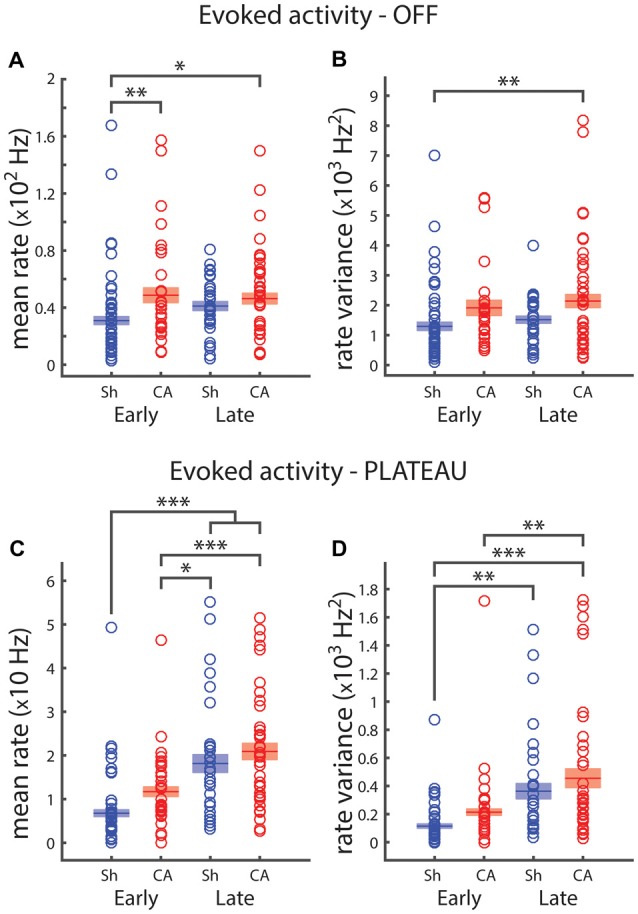
Plateau and OFF responses depend on development and are affected by ischemic injury. (A) Early sham average OFF response rate is significantly lower that both CA groups. (B) Firing rate variance of OFF whisker responses reveals that early sham response is less variable that late CA response. (C) Firing rates for the 125 ms plateau period preceding whisker offset. Early sham rate is smaller than both late group rates; early CA rate is smaller than both late group rates. (D) Early sham plateau responses are less variable than both late group responses; early CA firing rate variance is smaller than late CA firing rate variance. Horizontal bars and rectangular shaded regions indicate mean ± S.E.M. of the α-trimmed data sets. *Indicates p < 0.05, **indicates p < 0.01 and ***indicates p < 0.001.